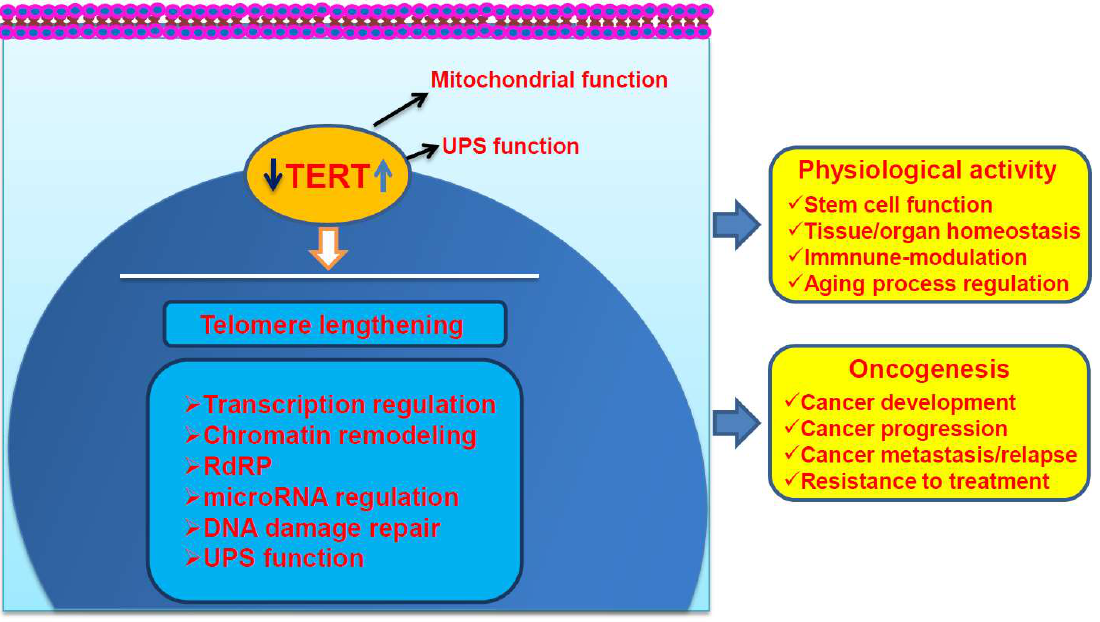
Figure 1. The telomere lengthening-dependent and independent functions of Telomerase Reverse Transcriptase (TERT). TERT / telomerase activation is required for both of physiological processes and transformation of human cells by stabilizing telomere length (telomere lengthening-dependent). The telomere lengthening-independent functions of TERT significantly contribute to both physiological processes and cancer initiation or progression, which include its e ff ects on mitochondrial, ubiquitin-proteasomal systems (UPS), gene transcription, microRNA (miRNA) expression, DNA damage repair, and RNA-dependent RNA polymerase (RdRP) activity. TERT may shuttle between the cytoplasma and nucleus. The e ff ect of TERT on UPS predominantly occurs in the nucleus but is also possible in the cytoplasma.